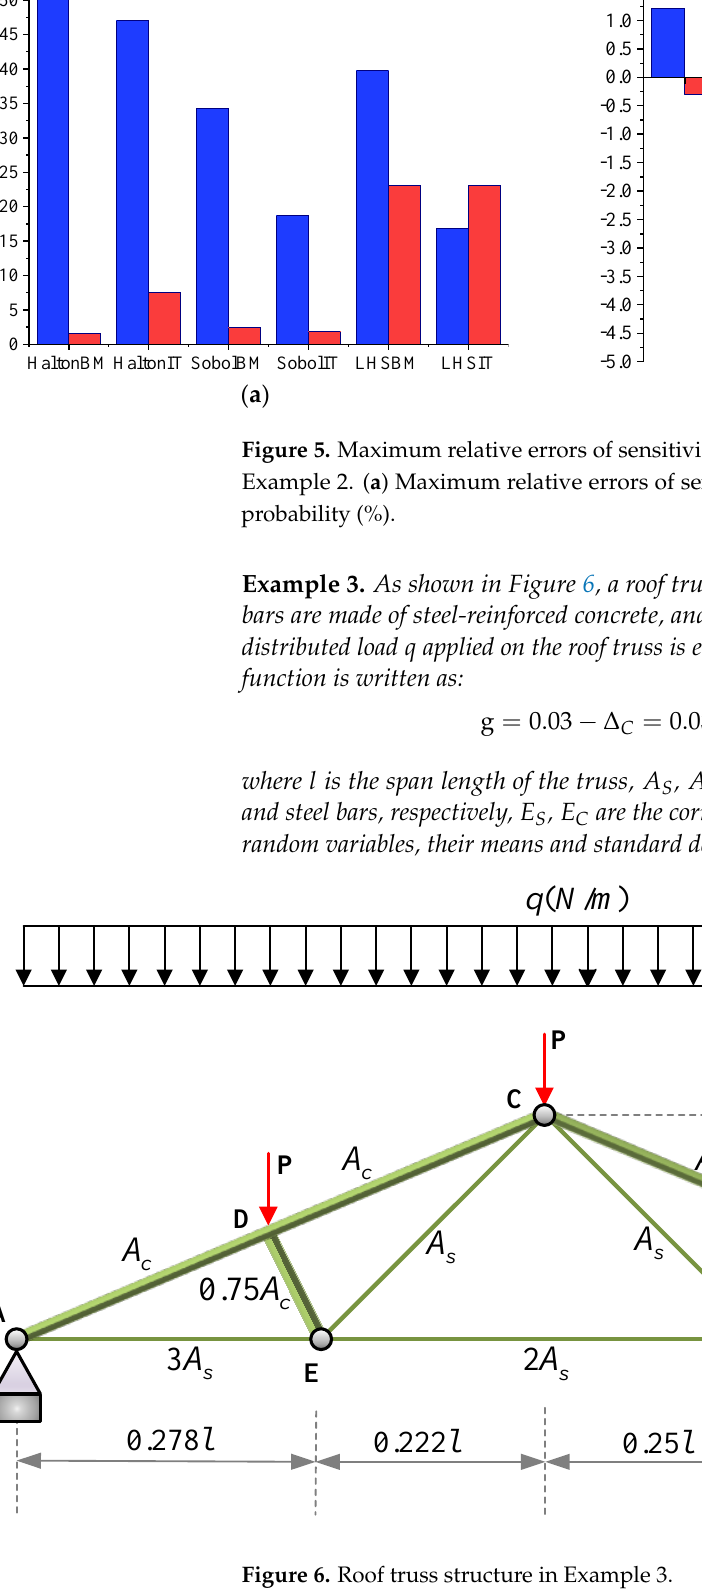
Figure 6. Roof truss structure in Example 3.